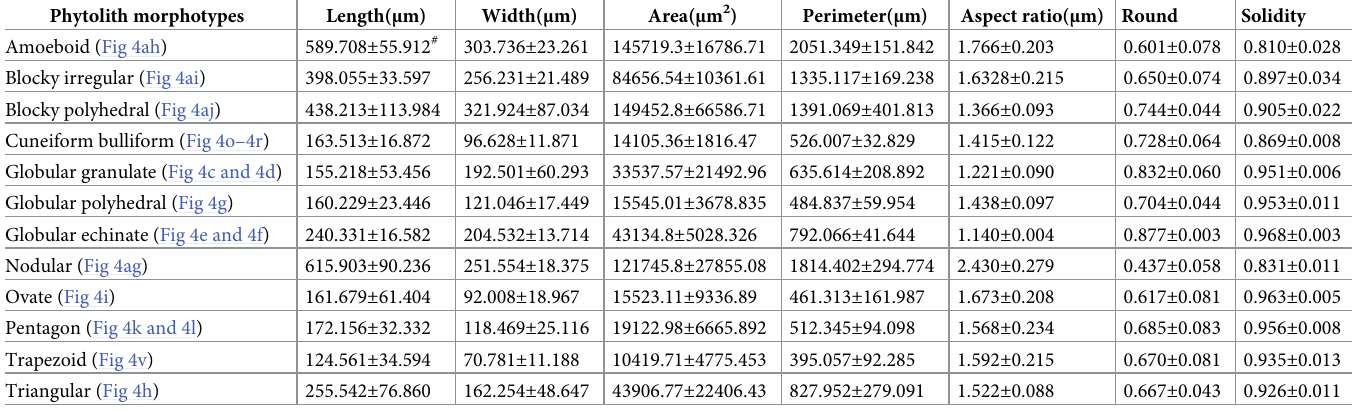
Table 3. Morphometry of phytolith morphotypes of Acrachne racemosa (Heyne ex Roem. & Schult.) Ohwi (Culm).